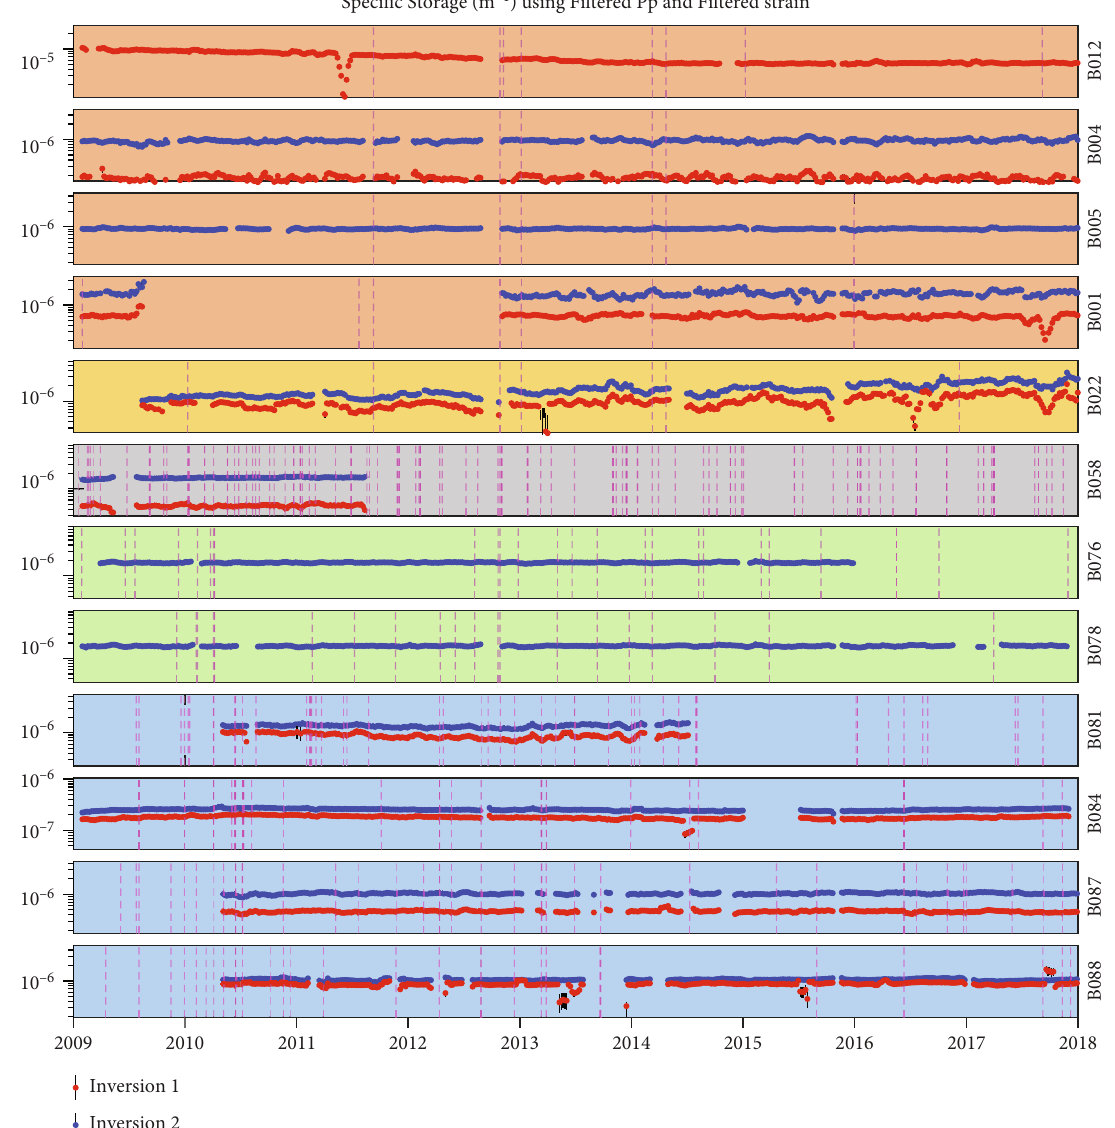
Figure 10: Speci fi c storage values over time for all boreholes. Earthquakes with a seismic energy density above 10 -3 J m -3 are plotted as magenta dashed lines. Error bars are within markers where not visible. Inversion 1 uses fi ltered borehole pore pressure and fi ltered modeled strain for analysis. Inversion 2 uses fi ltered borehole pore pressure and fi ltered strainmeter data for analysis. Background colors represent regions determined by geographic locality and similarity of local